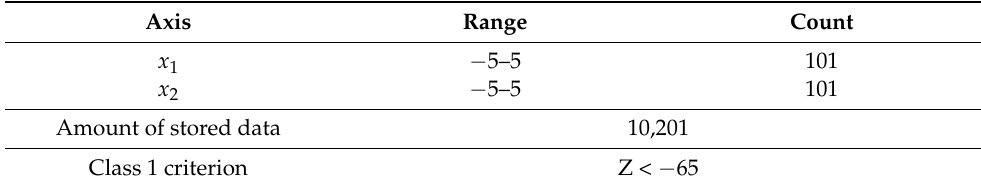
Table 4. Styblinski–Tang function